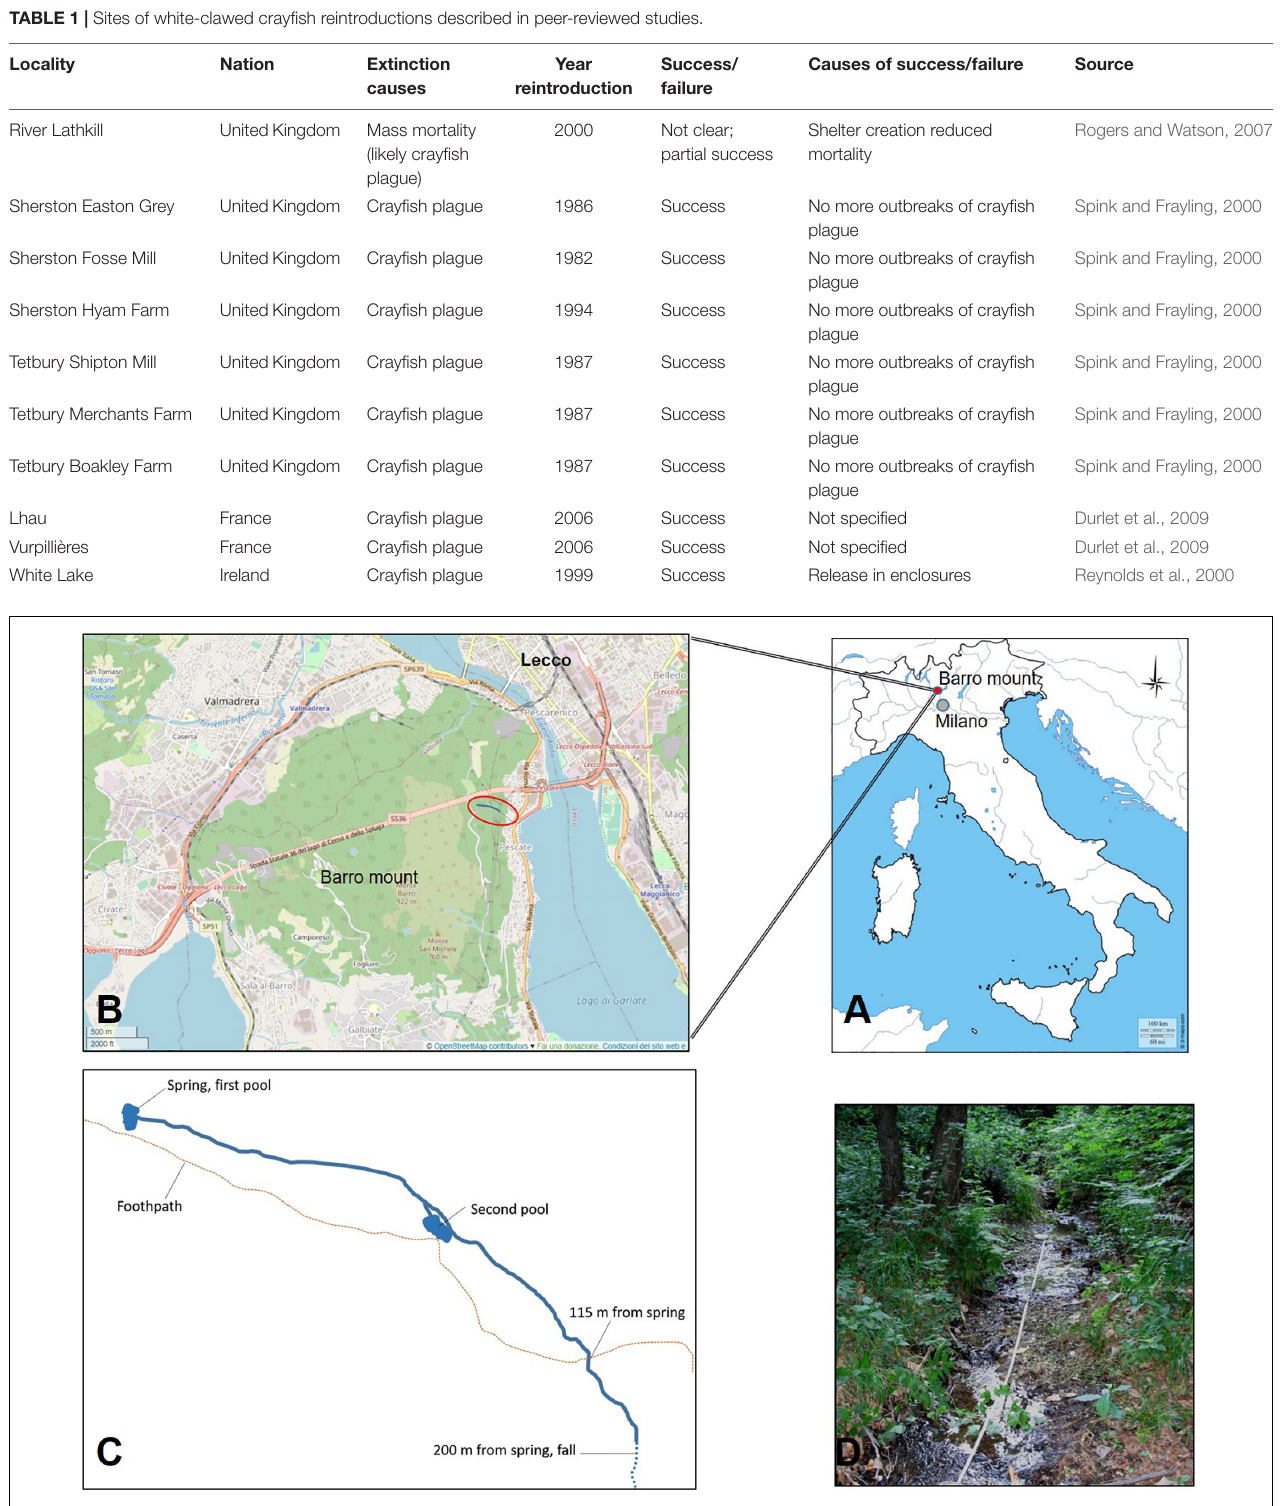
FIGURE 1 | Location (A,B) of the San Michele stream (C,D) where white-clawed crayfish reintroduction took place. In (B) , the red circle represents the location of the San Michele stream in the context of Mount Barro. (C) A schema of the San Michele stream where the main sites mentioned in the paper are indicated; the stretch between the stream spring and a waterfall with intermittent flow that makes a barrier for invasive crayfish species is 200 m long. Reintroduced white-clawed crayfish have been released in the two pools, built in 2009, and along the stream stretch 115 m long downstream from the spring. (C) Not drawn to scale.